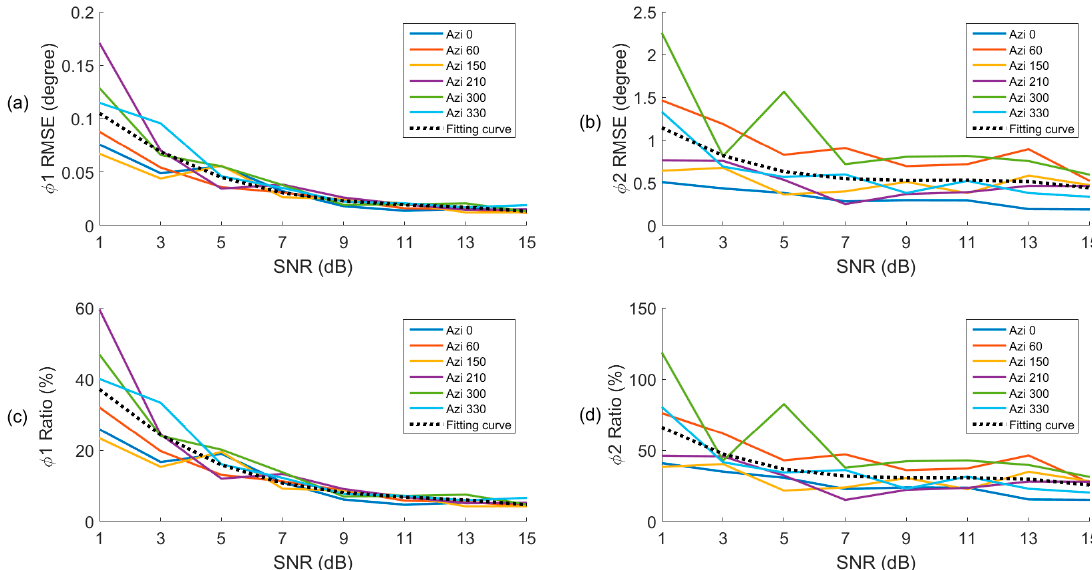
Figure 10. Root-mean-square error (RMSE) of angles ( a ) ϕ 1 and ( b ) ϕ 2 derived from DDMs with different SNRs and receiver’s azimuths. The ratio of RMSE to the corresponding amplitude of the oscillation of angles ( c ) ϕ 1 and ( d ) ϕ 2